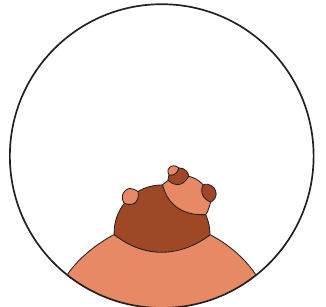
Figure 6.1 . The generating curve for a nonstandard area-minimizing double bubble in which the exterior intersects part, but not all, of the axis of rev- olution; the bubble consists of a topological sphere with a tree of toroidal bands attached, and the root of the tree has one branch.